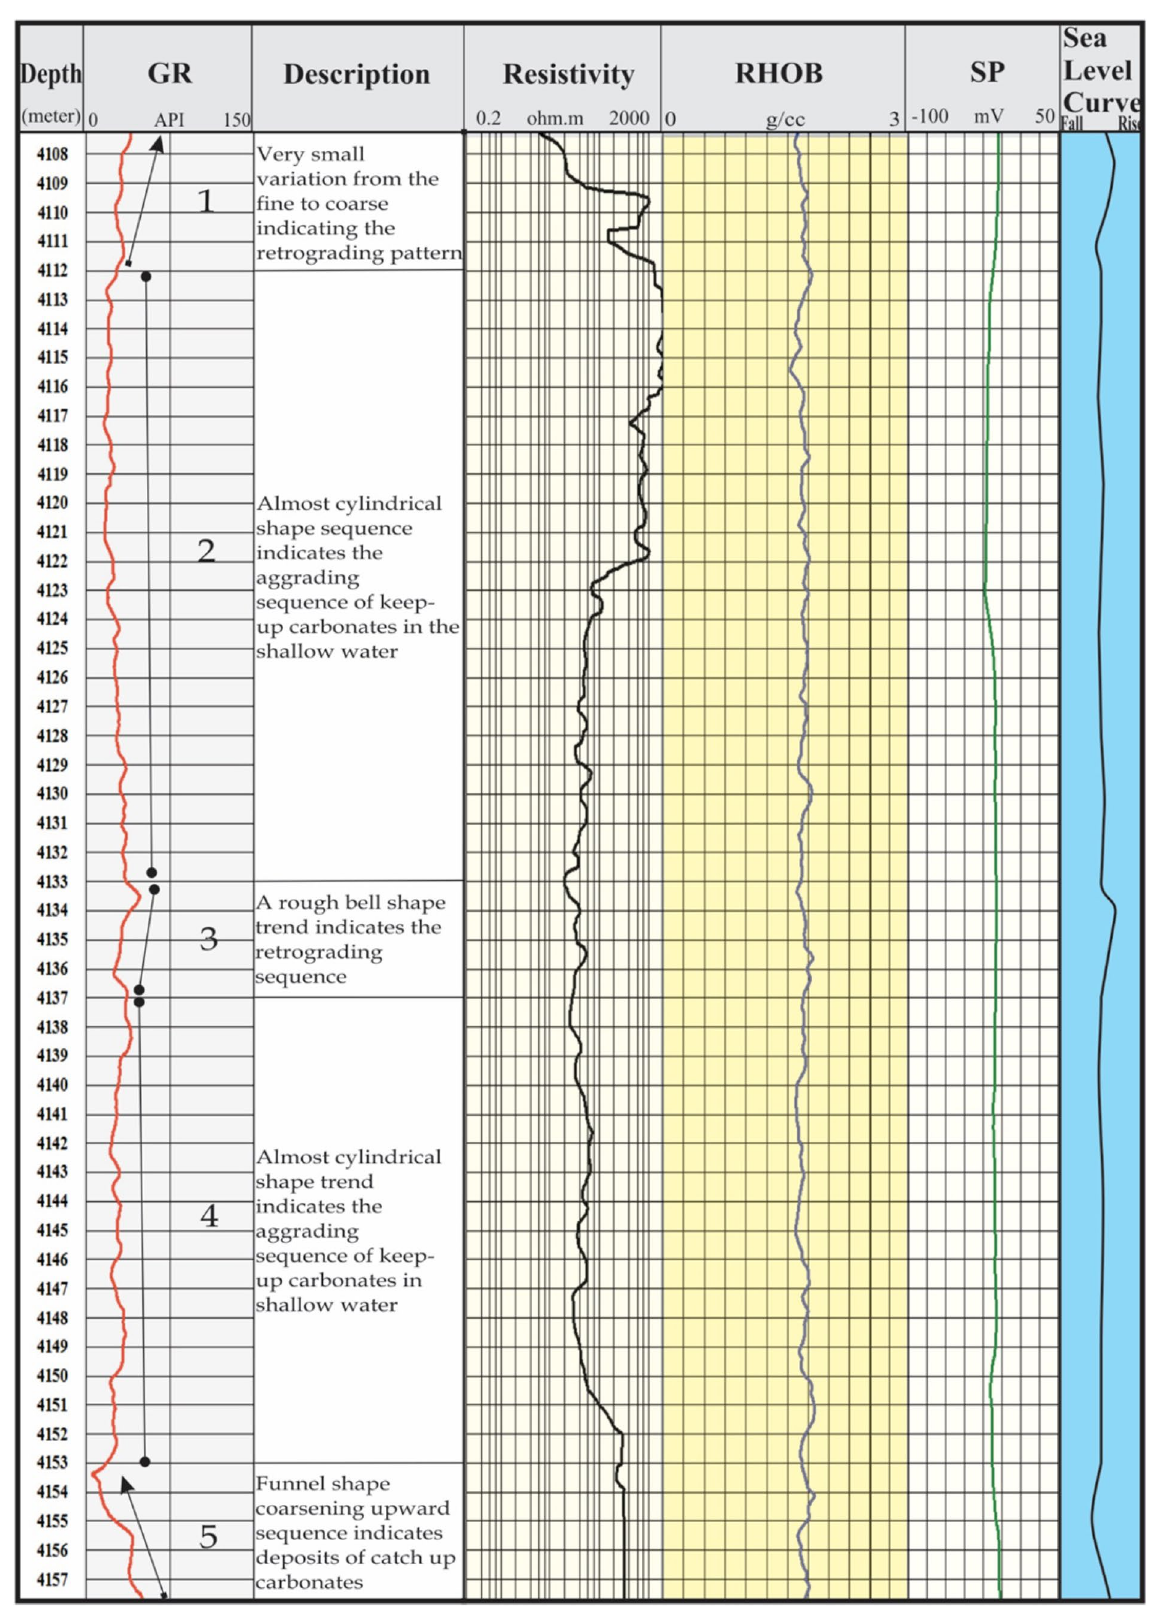
Fig. 19 Log response, depositional facies (electrofacies) and transgressive–regressive (T–R) sequences of the Lockhart Limestone in